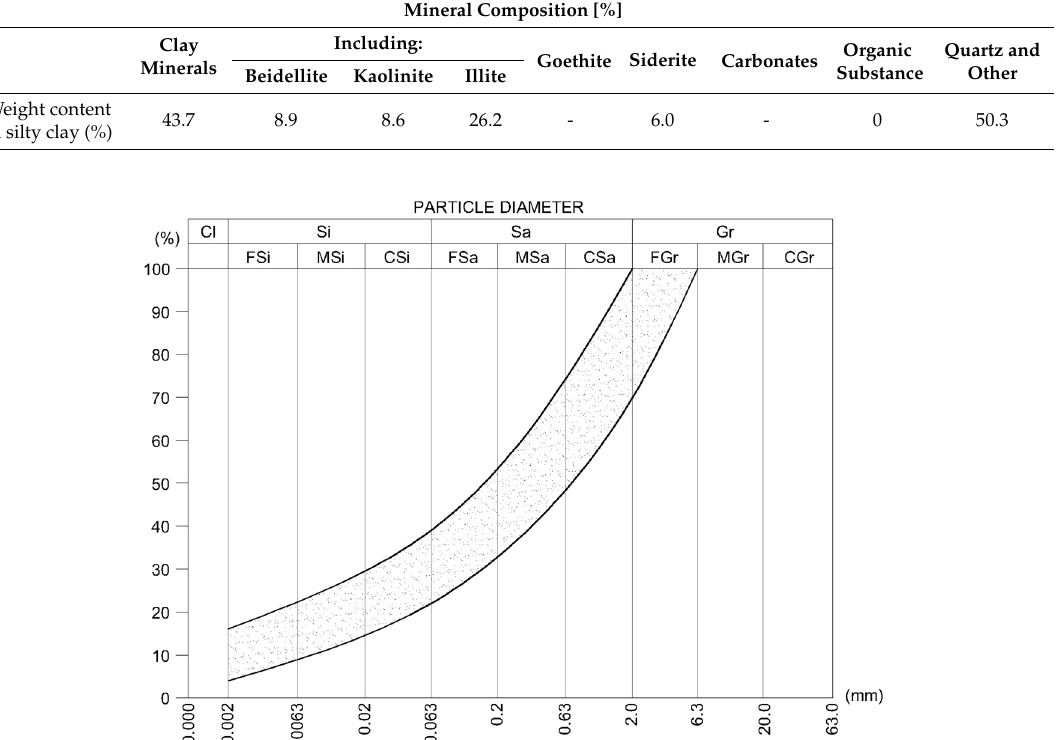
Table 1. Mineral and chemical composition of silty clay used in examined soil mixtures [5].